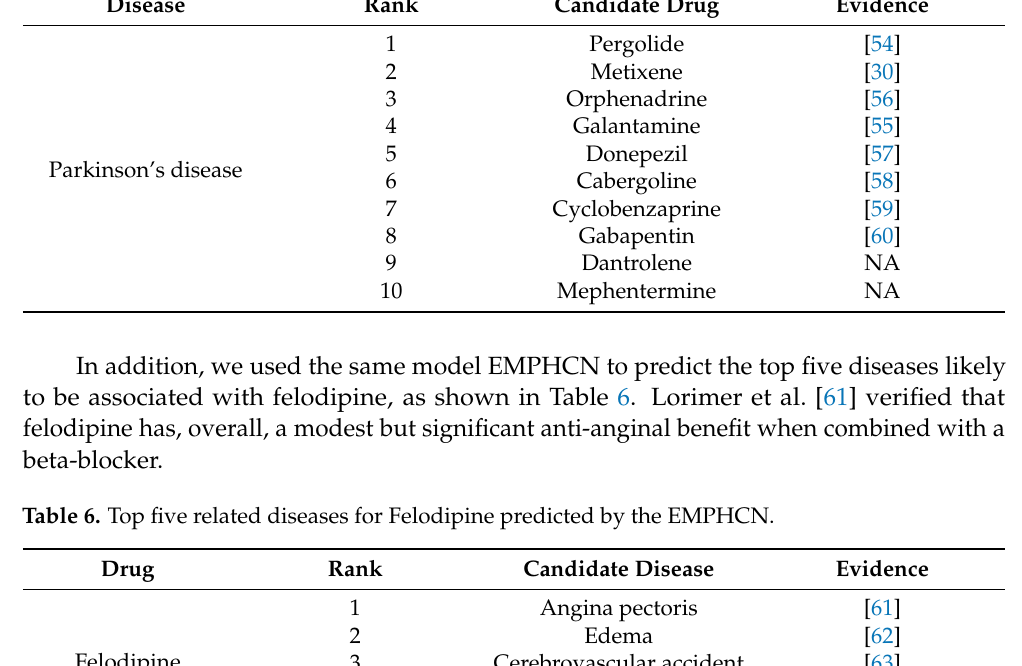
Table 6. Top five related diseases for Felodipine predicted by the EMPHCN. Drug Rank Candidate Disease Evidence 1 Angina pectoris [61] 2 Edema [62] Felodipine 3 Cerebrovascular accident [63] 4 Diabetic nephropathy NA 5 Congestive heart failure